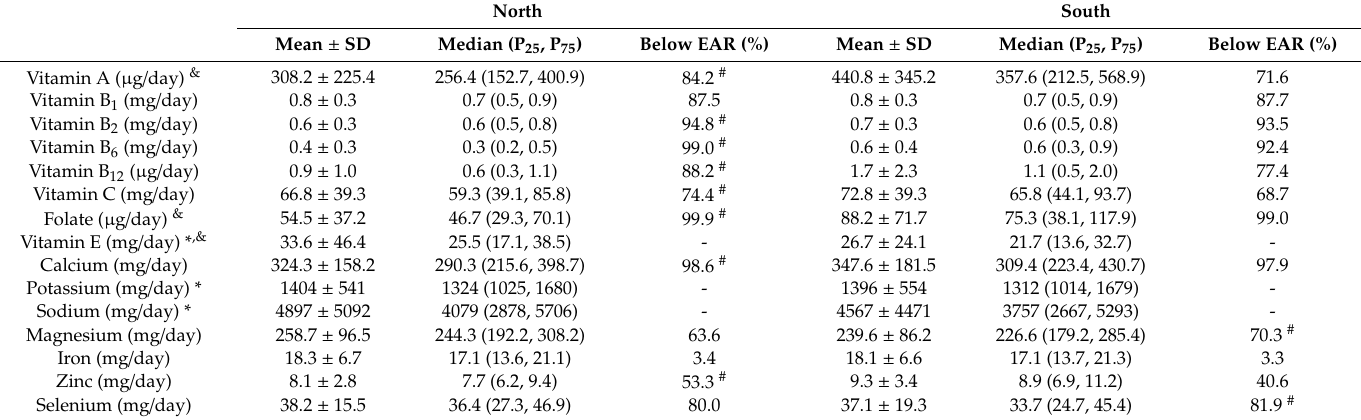
Table 4. Usual dietary intake and the prevalence of inadequate micronutrients in the elderly between northern and southern